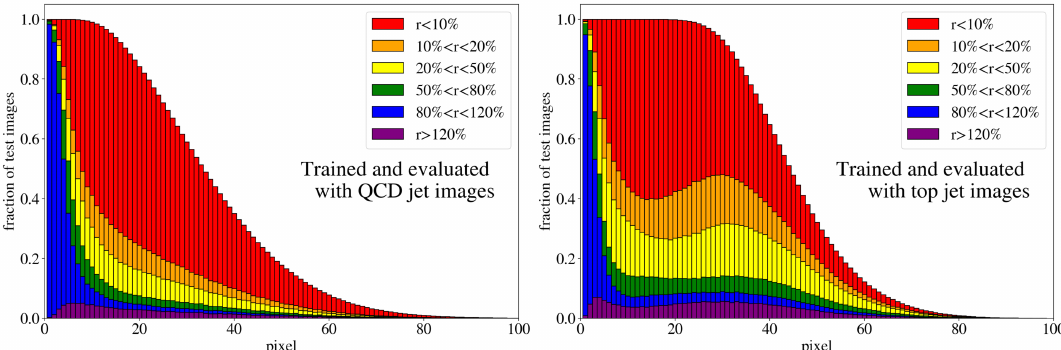
Figure 4 . Stacked histogram for different categories of the ratio r of the reconstructed and the input intensity of the non-zero pixels. Pixels are ordered by intensity from left to right for each of the 40k test jets. We show results for both QCD jets (left) and top jets (right), where the AE has been trained on the corresponding training